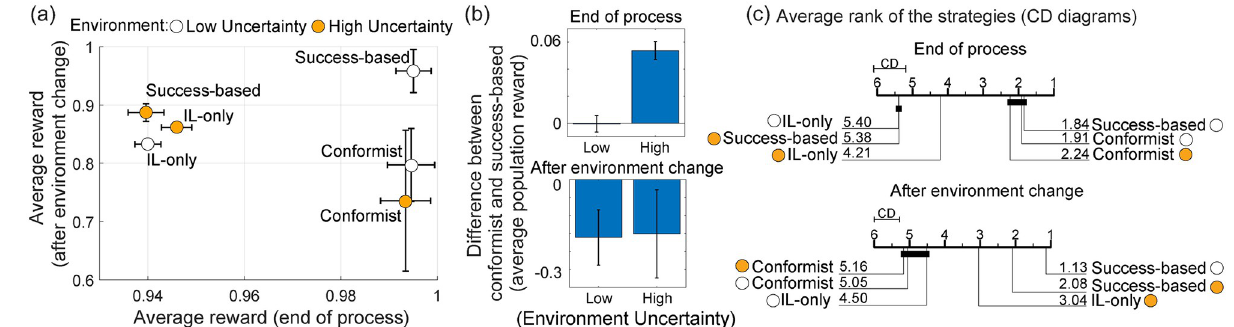
Fig 2. Performance of individual and success-based and conformist learning strategies. The success-based strategy shows the best performance in environments with low uncertainty, however, it suffers when there is uncertainty in the environment. On the other hand, the conformist strategy achieves similar performance independent of the environment uncertainty. (a) The average rewards achieved by the strategies after an environment change vs. at the end of the processes in environments with high and low uncertainty. (b) The difference in the performance of conformist vs success- based strategies. After an environment change, the performance achieved by the success-based strategy is higher in low and high uncertainty environments, whereas, at the end of the processes, they achieve similar results only in low uncertainty environment. On the other hand, in high uncertainty environment the performance of the conformist strategy is higher. Finally (c) provides the Critical Difference diagrams (CD) shows the average ranks of the the strategies (given by decimal numerals in each line that represent a strategy) based on their performance after an environment change and at the end of the processes. Lower ranks demonstrate better performance in terms of average population reward achieved by the strategies. The strategies are linked (via bold thick lines) if their average ranks are not statistically significant based on the post-hoc Nemenyi test at α = 0.05 [48,